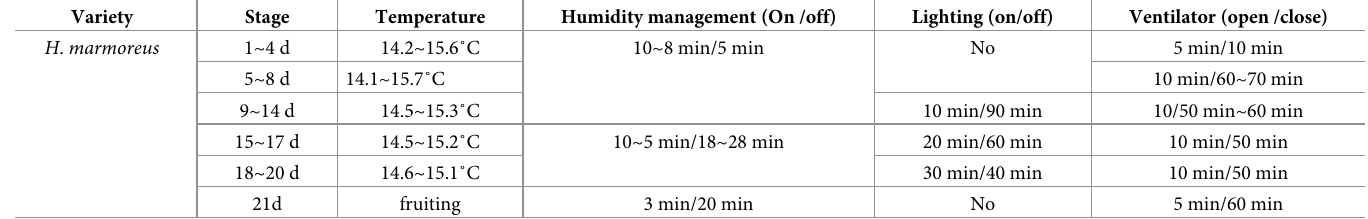
Table 1. Control parameters of mushroom house.